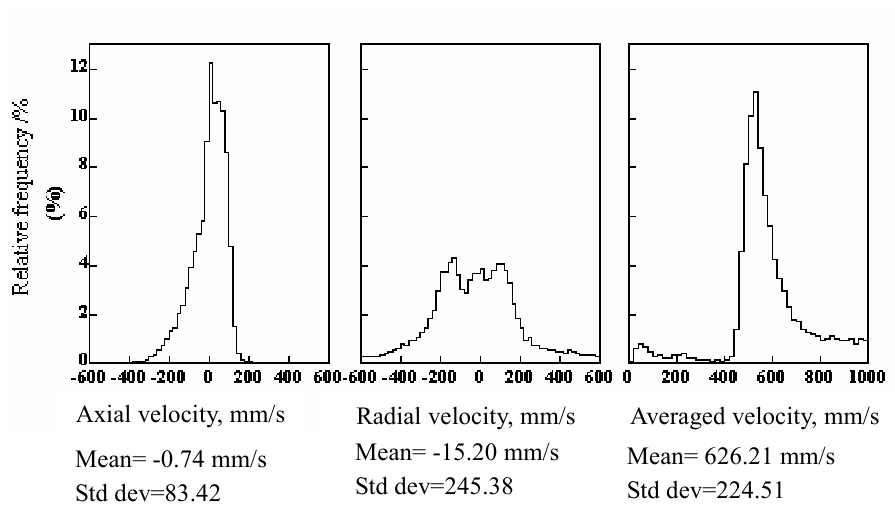
Axial velocity, mm/s Radial velocity, mm/s Averaged velocity, mm/s Mean= -15.20 mm/s Mean= 626.21 mm/s Mean= -0.74 mm/s Std dev=245.38 Std Std dev=83.42 Fig.6 Velocity histograms from PEPT measurement for 3 beveled blades, 600rpm. (a) Axial velocity, (b) radial velocity, (c) Averaged velocity Figure 7 shows the averaged velocity distribution for the two blade designs as a function of axial position and averaged velocity. This velocity distribution was calculated using the six point method, as described above. Further, the distribution of the velocities in the flat blade design was greater than in the beveled blade design, and the velocity of particles was much higher in the flat blade design, particularly near the blade. This indicates that there are marked differences both in the swept volume and in the flow Fig.7 Averaged velocity distribution pattern between the two blade designs. As is clear from the figure, the beveled blade design